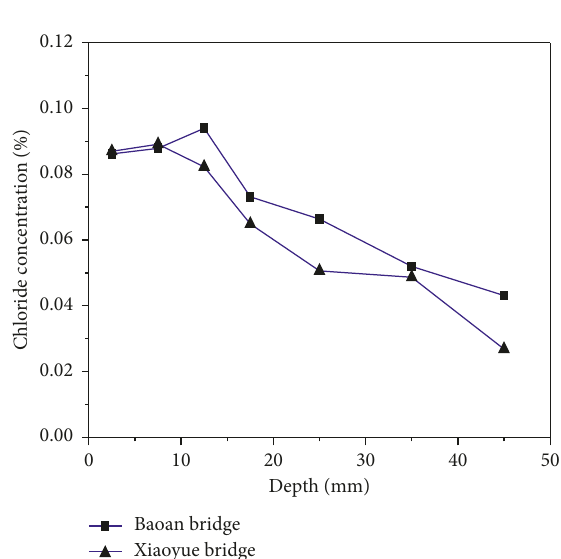
Figure 8: Comparison of the chloride profile between Baoan bridge and Xiaoyue bridge.